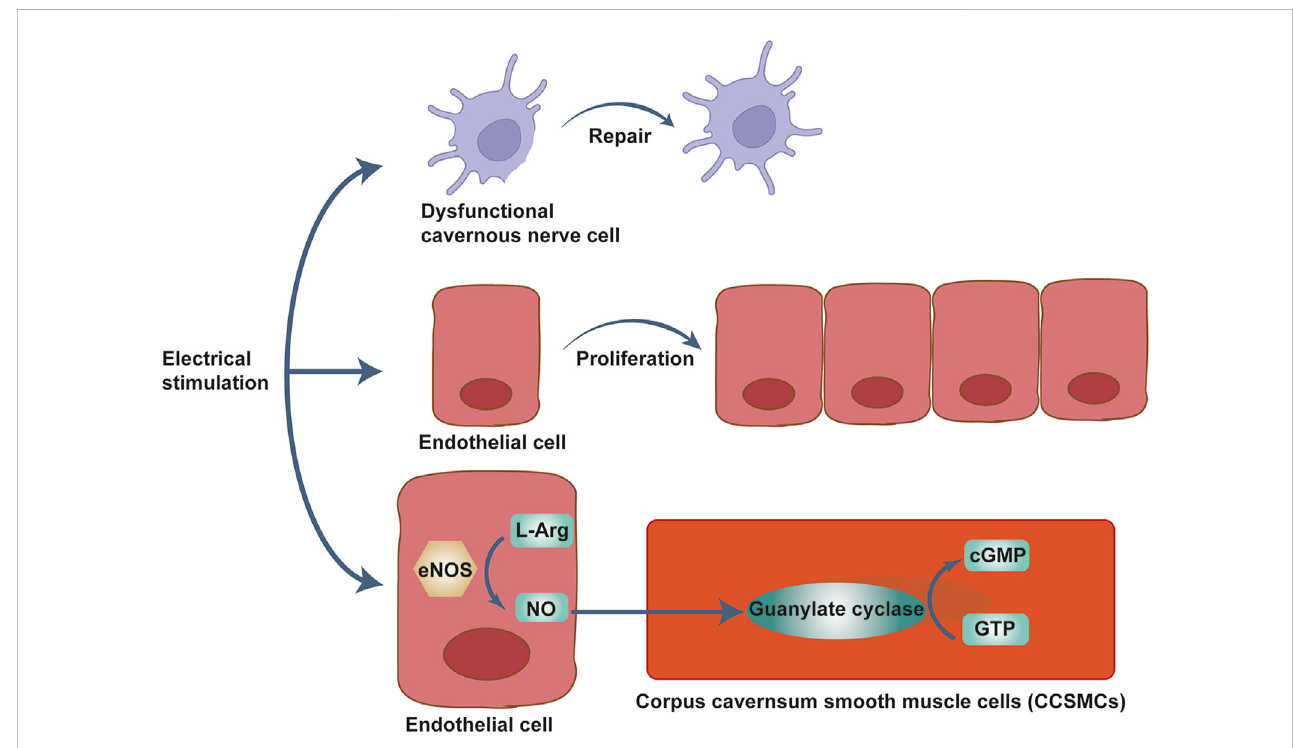
FIGURE 2 Mechanism of ES for the treatment of ED. Electrical stimulation treats erectile dysfunction by promoting cavernous smooth muscle proliferation, repairing cavernous nerves, and increasing endothelial cell NO.